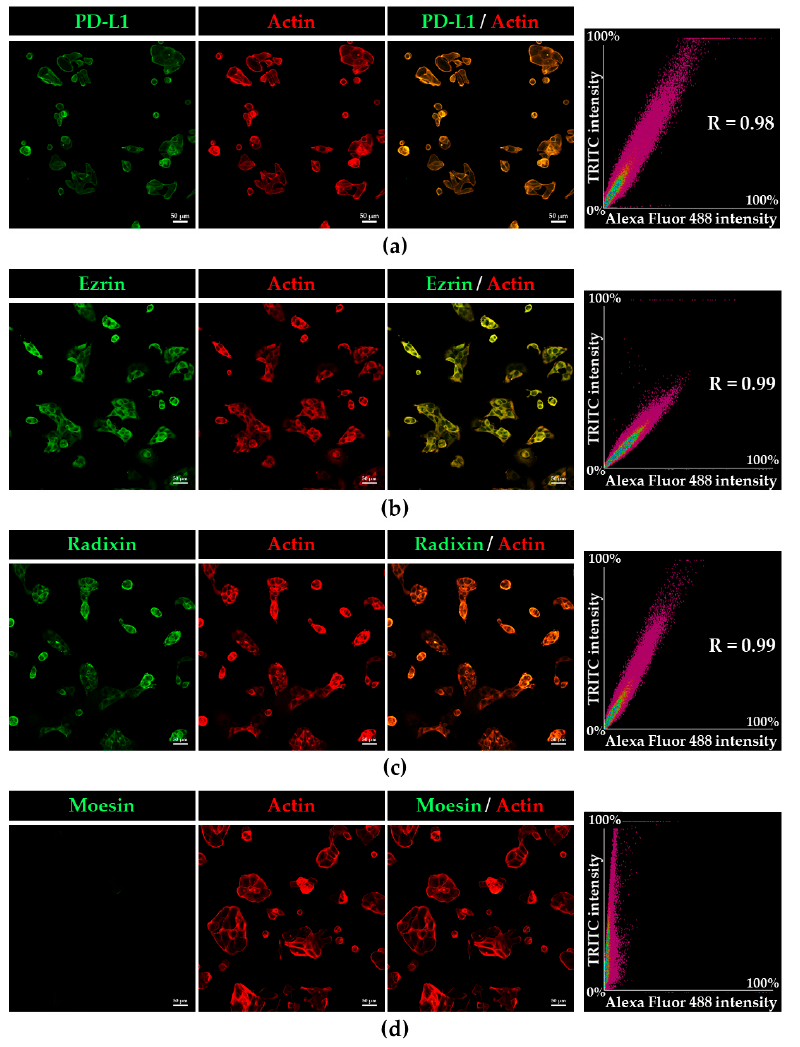
Figure 2. Confocal laser scanning microscopy analysis for intracellular distribution of programmed death ligand-1 (PD-L1), ezrin, radixin, and moesin (ERM) in KP-2 cells. In a three-dimensional reconstruction of optically sectioned KP-2 cells, ( a ) PD-L1, ( b ) ezrin, and ( c ) radixin (green) labelled with Alexa Fluor 488, were highly colocalized with F-actin (red) labelled with phalloidin-conjugated to tetramethylrhodamine (TRITC). ( d ) Moesin (green) was hardly detectable in KP-2 cells. Scale bars: 50 µm. Right panels represent the correlation plot between Alexa Fluor 488-labelled PD-L1 or each ERM and TRITC-labelled F-actin. Each value in the plots was Pearson’s correlation coefficient. All data are representative of at least three independent